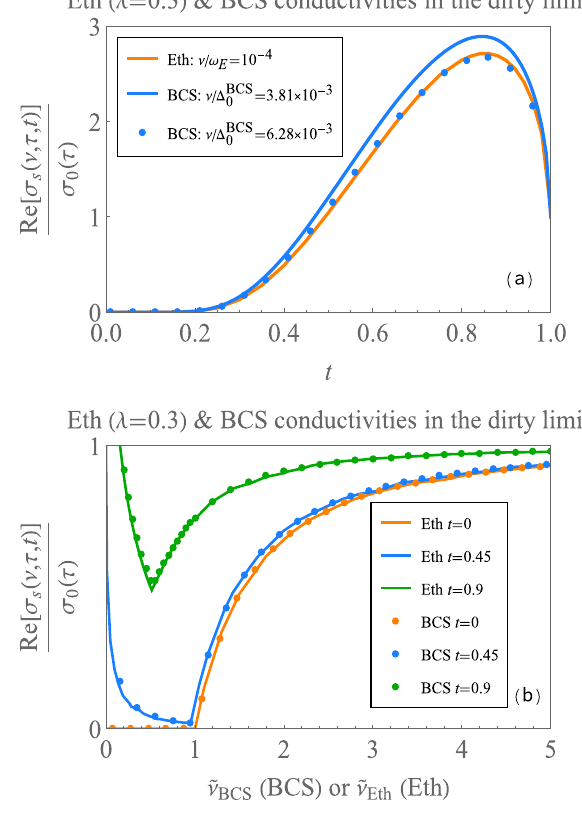
¼ ð ν = ω Þð ω = Δ BCS Þ (cid:7) E E 0 0 . In the case of 0